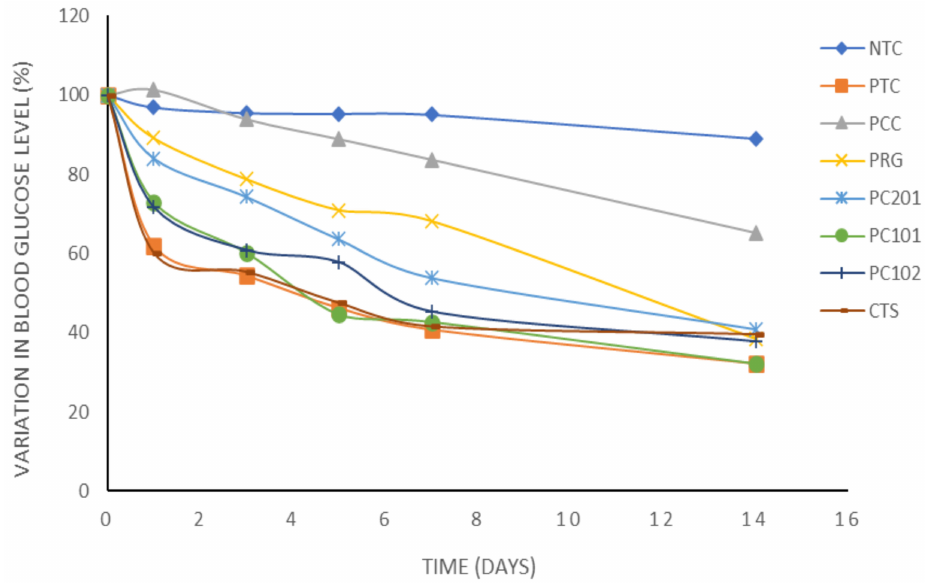
Figure 4. Antidiabetic effect over a 14-day period with daily administration of the various formulations (NTC = negative control, PTC = positive control, PCC = unloaded nanoparticles, PRG = prosopis gum-based insulin nanoparticles, PC201 = Prosochit ® 201-based insulin nanopar- ticles, PC101 = Prosochit ® 101-based insulin nanoparticles, PC102 = Prosochit ® 102-based